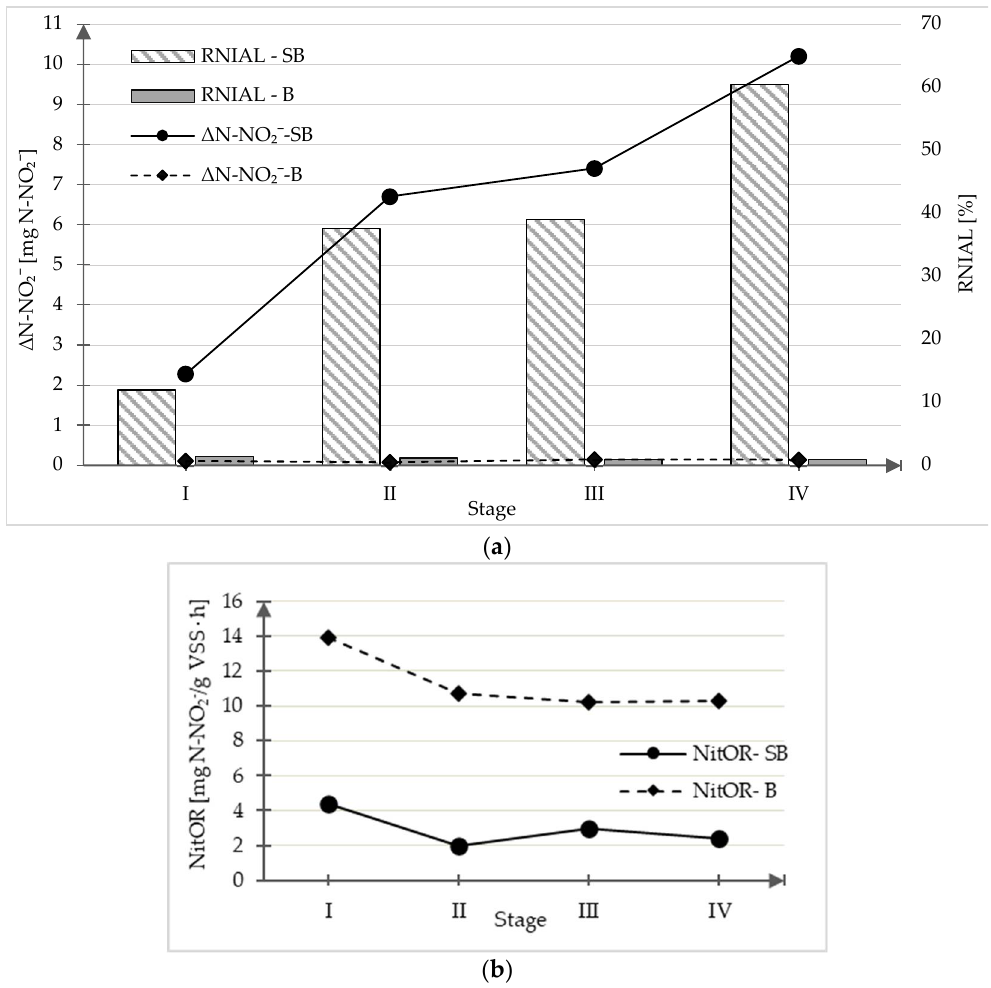
Figure 3. ( a ) Accumulation of nitrites (ΔN-NO 2- ), RNIAL values, ( b ) nitrite nitrogen oxidation rate (NitOR) for suspended biomass (SB) and biofilm (B).